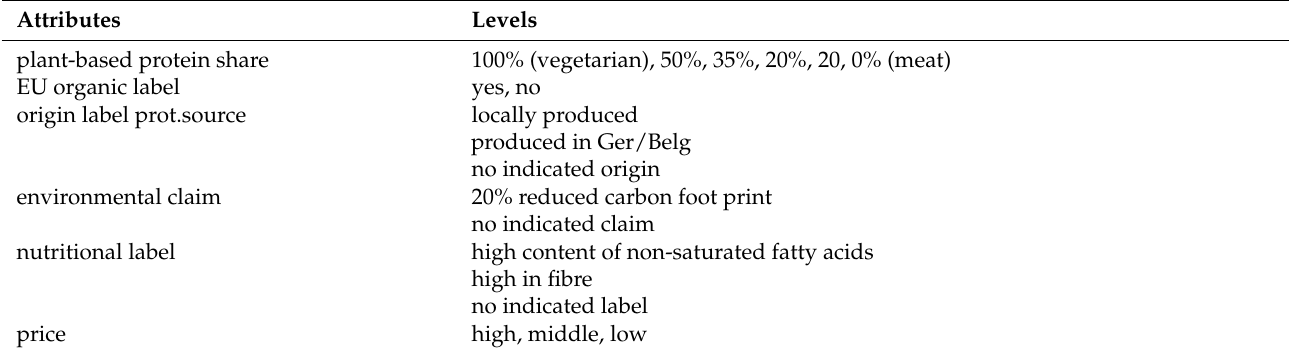
Table 2. Attributes and attribute levels used in the Discrete Choice Experiment